Question: What kind of plot is shown here?
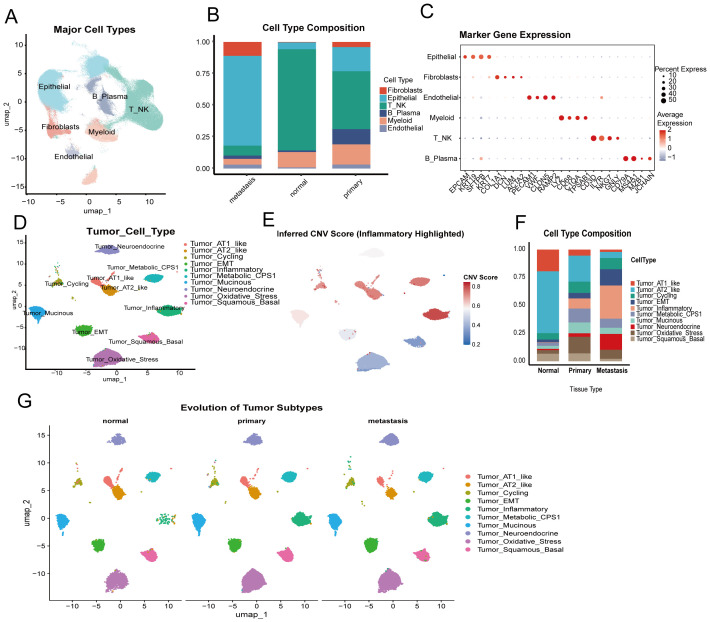
Answer: scatter